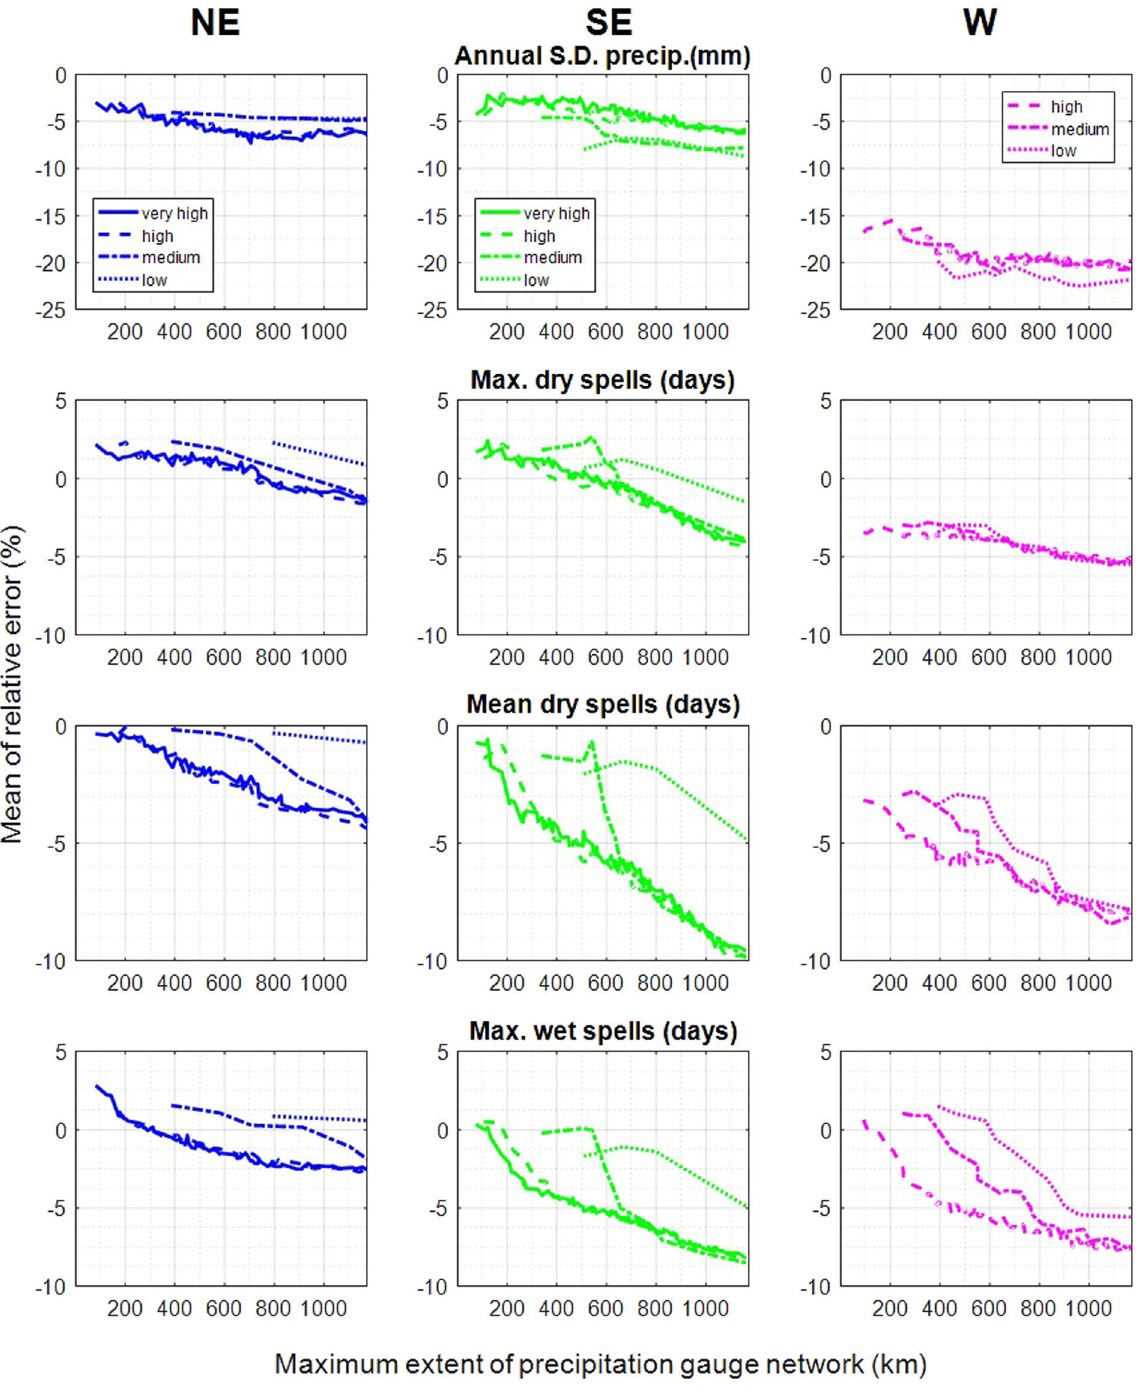
Figure 4. Relative error for all sites in the North-East (NE), the South-East (SE) and the West (W) for all months. The error is plotted for four metrics against the maximum extent of each simulated gauge network and density scenario. For each study area and scenario, the lines show the mean of the four simulations (using four different starting sites; see Fig. 1). The solid line represents the results for the very-high gauge network density (not available for the West), the dashed line for the high-density, the dash-dot line for the medium density and the dotted line for the low gauge density